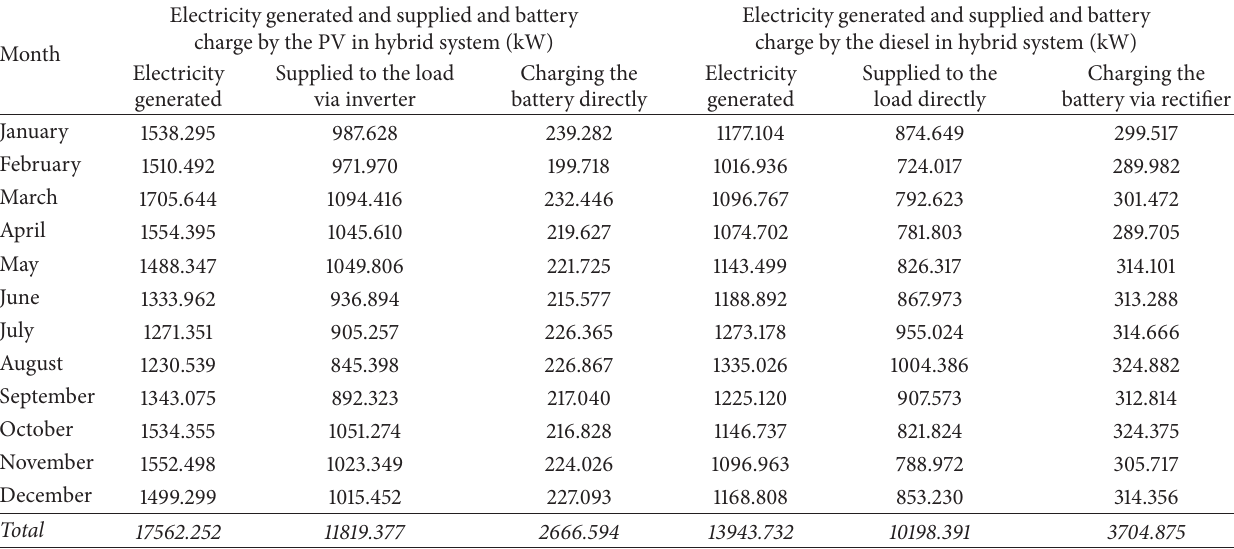
Table4:Resultsofeachoftheenergycomponentsofthehybridsystem(PVanddiesel)forelectricityproduction,supply,andbatterycharging